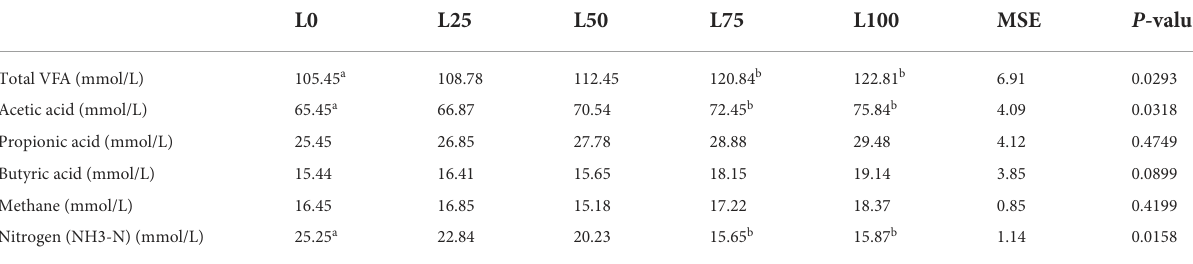
TABLE 4 In vitro gas production after 48-h in vitro digestion in different substitution treatments of lucerne with lemon pomace by-product after 60 days of